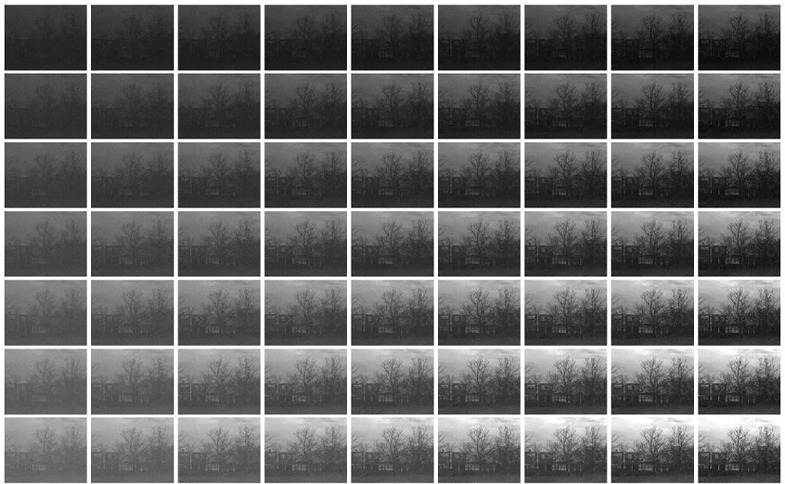
Range of illumination conditions.Average luminance increases from top to bottom and contrast increases from left to right. Luminance is in the range [0, 160] cd/m2. Average luminances are in the range [25, 80] cd/m2, and average contrasts are in the range [0.1, 0.9]. The learning-based decoders were trained with natural images from the central luminance/contrast condition, under two levels of distortion. The undistorted image comes from the publicly available Van Hateren database [101] and is reproduced here with permission from Hans Van Hateren.